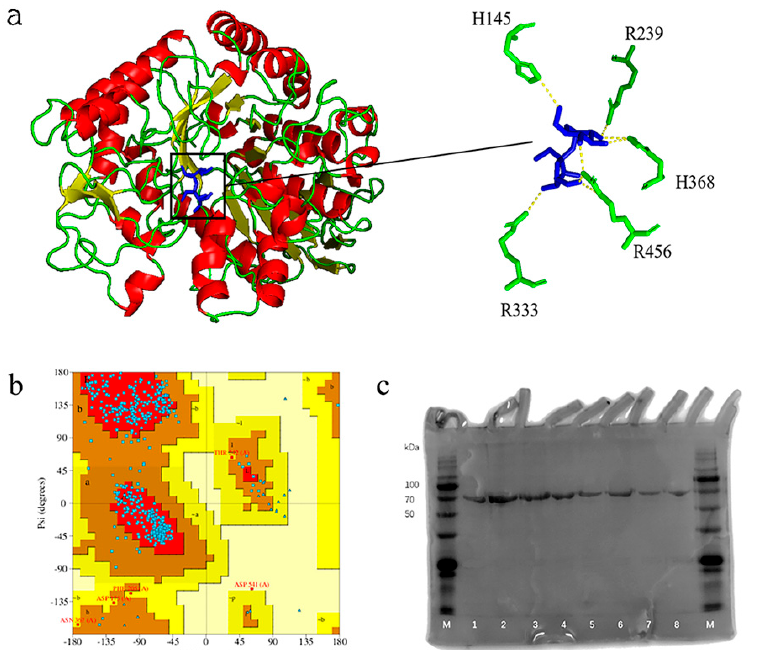
Figure 5. Construction and expression of mutants. ( a ) The binding sites of Pal-2 and sucrose. ( b ) Ramachandran plot of Pal-2 modeling structure. ( c ) SDS-PAGE of the Pal-2 mutants. Lane M, represents molecular weight marker, Lane 1–8 represents N498P, Q275R, V355A, A492E, Y246L, H481P, R310P, and H287R, respectively.